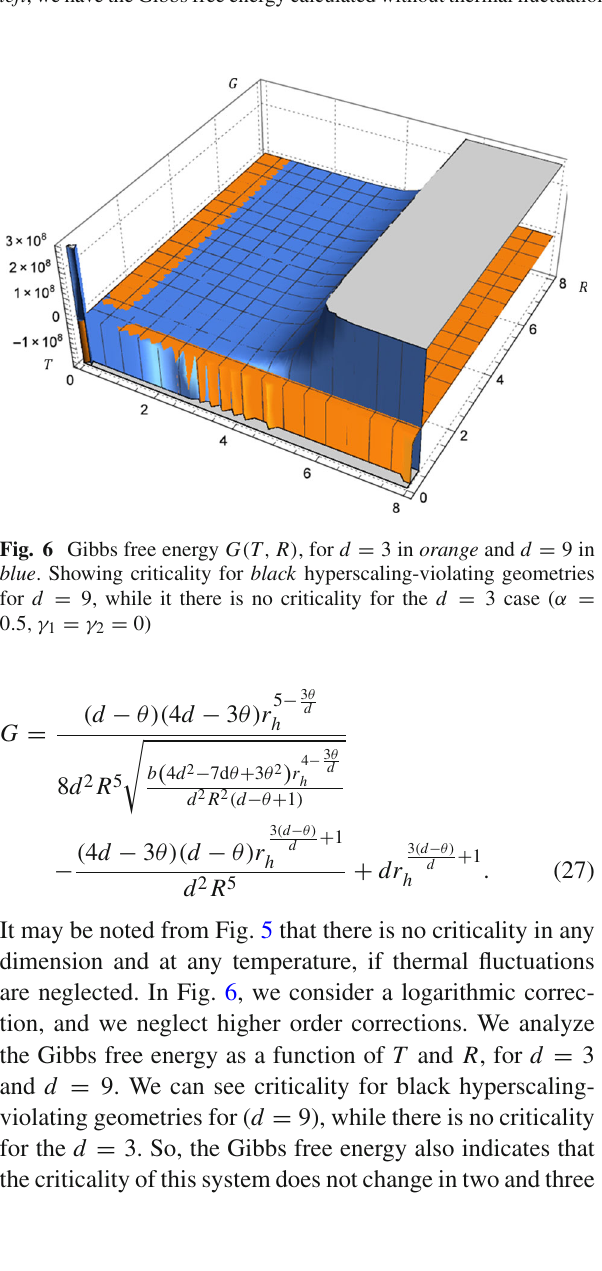
Fig. 5 Gibbs free energy as a function of temperature, for different space dimensions d = 2 blue , d = 3 yellow , d = 8 green and d = 9 red . On the left , we have the Gibbs free energy calculated without thermal fluctuations. On the right , thermal fluctuations are considered ( α = 0 . 5 ,γ 1 = γ 2 = 0)